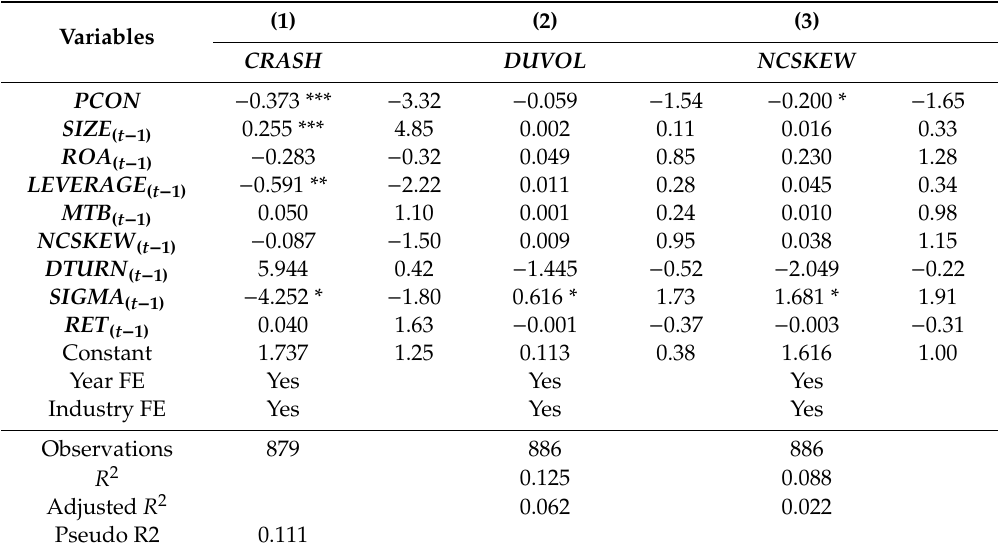
Table 7. Results of regression of political connections on stock price crash risk (including year of Suharto’s resignation, 1998).